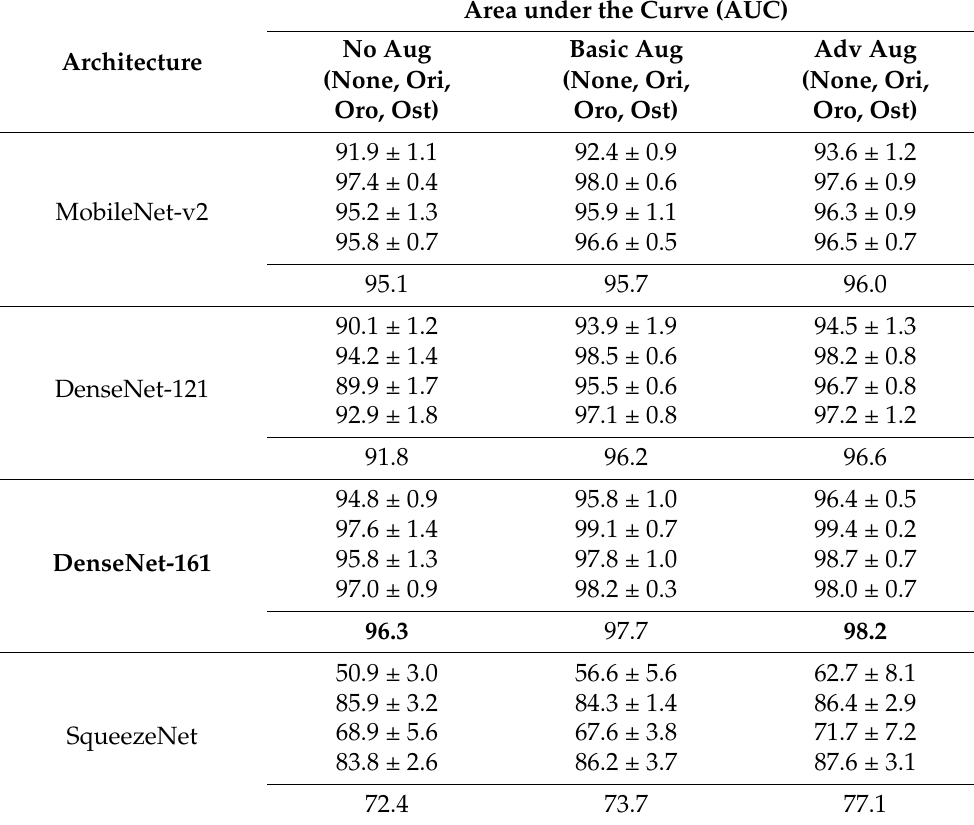
Table 2. The summary of the results obtained for No Aug , Basic Aug , and Adv Aug configurations is provided hereunder. The bold text represents the best value of the corresponding parameter among all CNN models, which is mean over all four